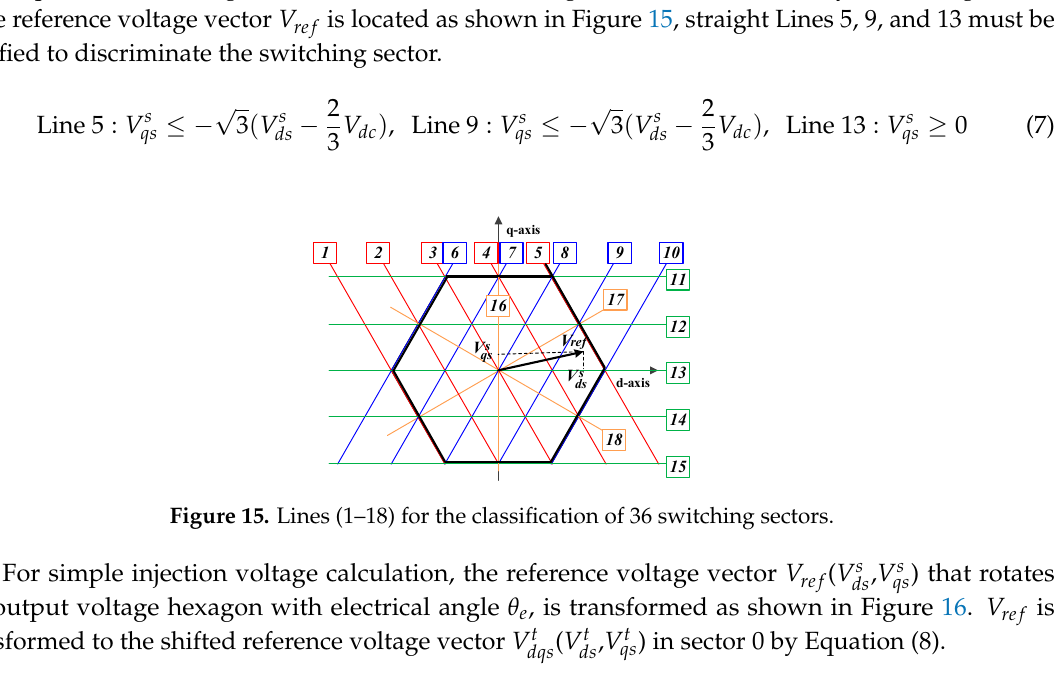
( b ) Figure 16. Transform shifted sector. ( a ) Shifted sectors (0~5); ( b ) shifted sector (0).